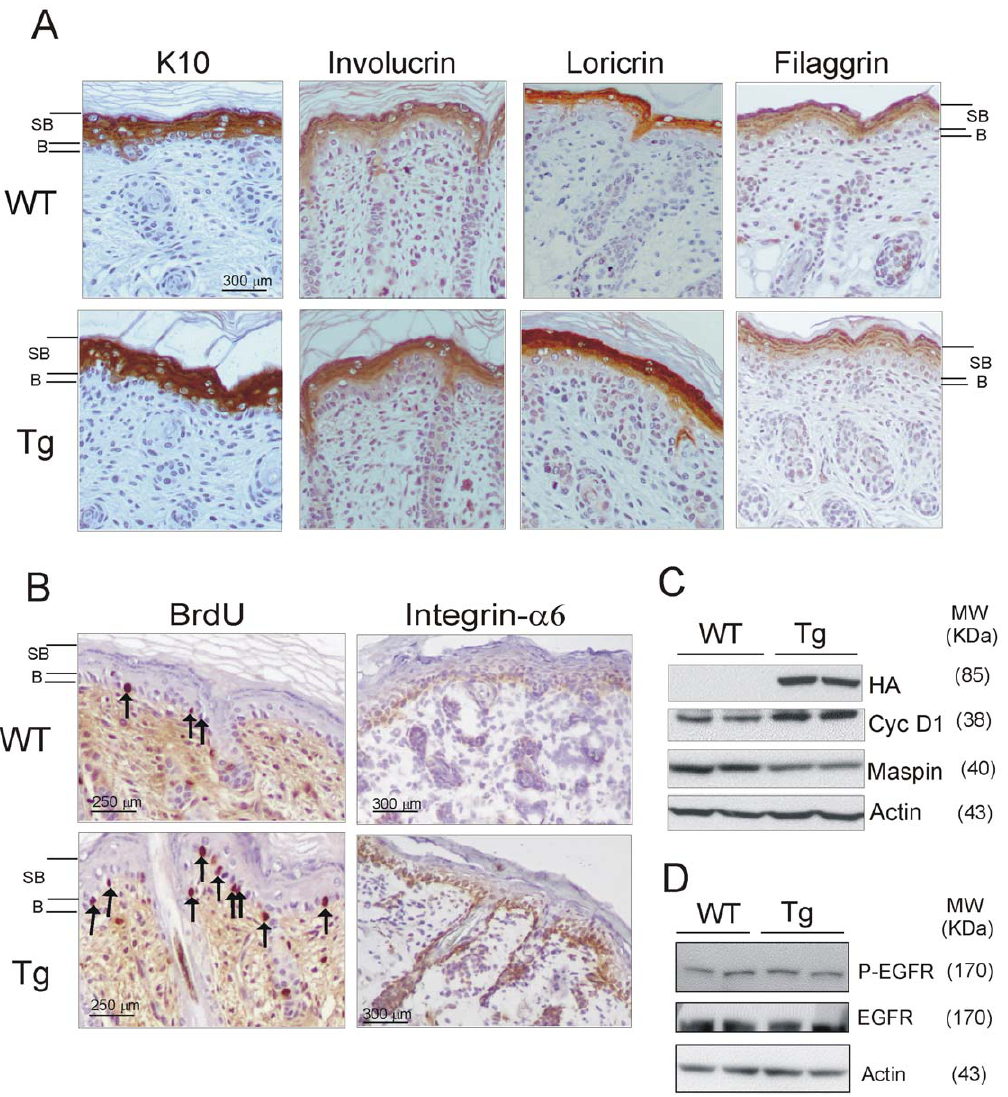
Figure 2. Alterations found in back skin of K5-IKK a -Tg mice. ( A ) Immunohistochemical analysis of epidermal differentiation markers in back skin of 3-day-old WT and K5-IKK a mice. No differences were found between mice of both genotypes. B, SB, basal and suprabasal keratinocyte layers respectively. ( B ) Images show the increased number of basal keratinocytes that incorporate BrdU in epidermis of Tg mice. Integrin a 6 is expressed in basal as well as suprabasal keratinocytes in skin of Tg mice. ( C; D ) Analysis of cyclin D1 (Cyc D1), maspin and EGFR protein levels as well as EGFR phosphorylation (P-EGFR) in total protein extracts of skin of WT and K5-IKK a -Tg mice. Total proteins from backskin of two different mice of the line L1 and two different control littermates were loaded. keratohyaline granules. In Tg mice, TPA application also induces skin of WT and Tg mice in the second telogen phase of the hair hair follicle anagen phase and epidermal hyperplasia (Figure 3 follicles. As expected, 3 weeks of treatment provoked in WT compare C and D). However, in these mice the hyperplasia was animals the entry of hair follicles into the anagen phase as well as associated with epidermal atypia, characterized by a disorganized the development of epidermal hyperplasia (7 to 10 layers of architecture of the different keratinocyte layers where cells lose epidermal keratinocytes versus 2 to 4 layers observed in non-treated their polarity and normal differentiation; it was not possible to epidermis of adult mice; Figure 3 compare A and B). We observed distinguish the stratum basale, spinosum and granulosum because most that the hyperplasia was due to an increase both in the stratum spinosum and granulosum (see inset in B). This hyperplasia exhibit the keratinocytes appeared as round cells with central nucleus and there was no sign of terminal differentiation (i.e. lack of typical increase in epidermal thickness, with keratinocytes of the stratum basale containing nuclei perpendicular to the basal keratohyaline granules in the upper suprabasal layers) (see inset in Figure 3D and compare with inset in B). There was also a great membrane; keratinocytes of the stratum spinosum with round, heterogeneity in the nuclear staining of keratinocytes from Tg- central nuclei; and keratinocytes of the stratum granulosum showing TPA-treated mice showing many condensed, highly basophilic progressive flattening of the cells, in parallel to the basal pyknotic nuclei. Elevated rates of keratinocyte proliferation membrane, with smaller nucleus and scarce cytoplasm filled with